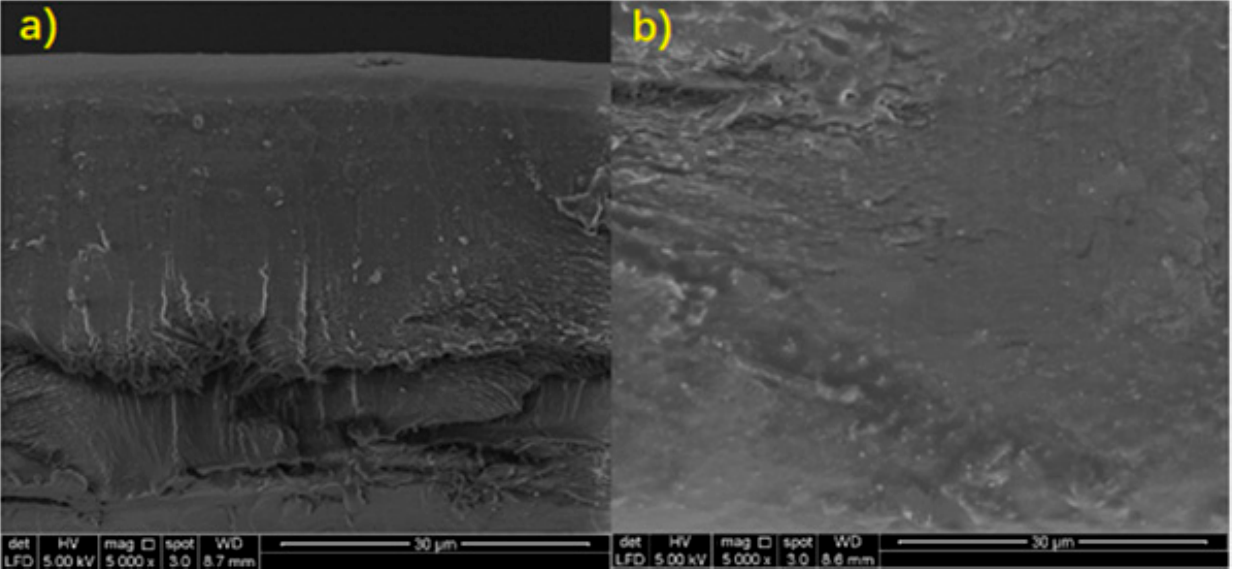
Figure 5. Cross-sectional scanning electron microscope (SEM) image of ( a ) sodium alginate film and ( b ) 0.5 g microbial composite film.